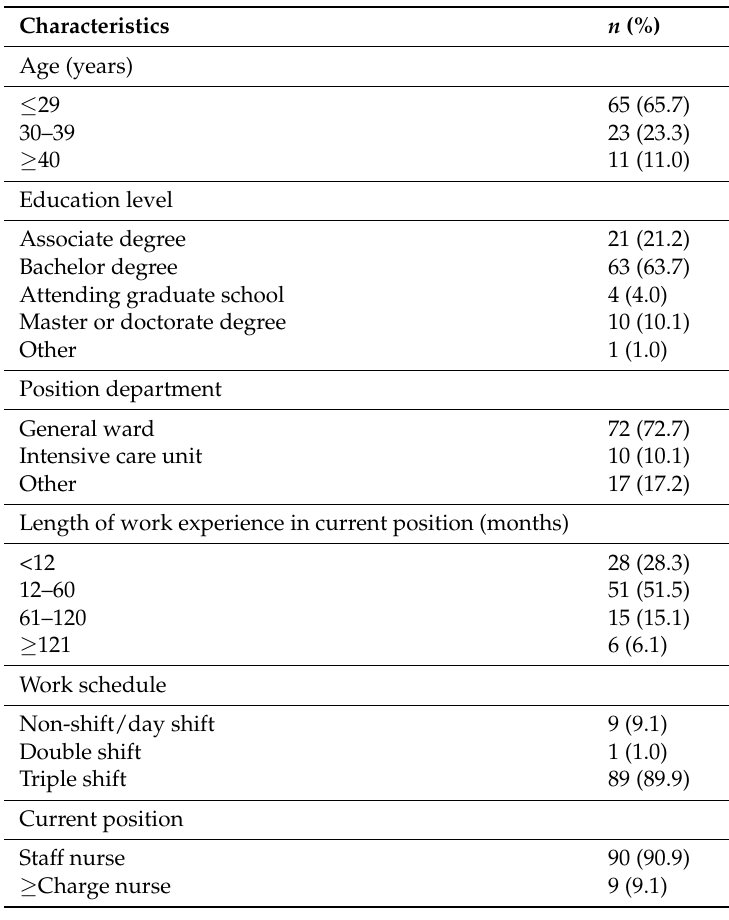
Table 1. Summary of demographic characteristics ( N =